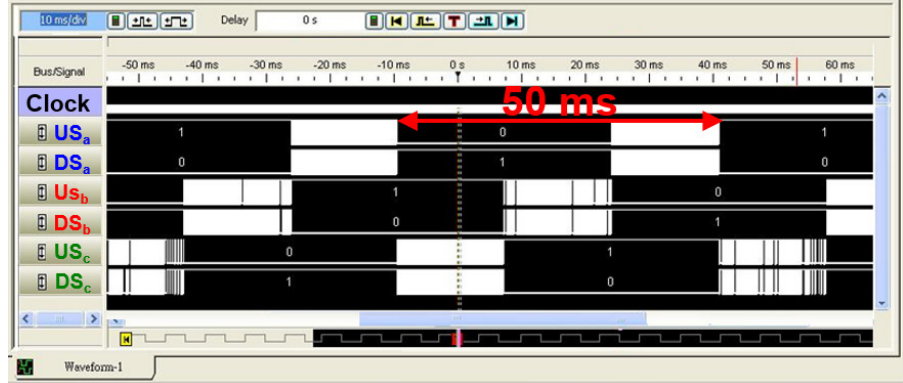
Figure 18. Behavioral simulation of waveforms of six–arm voltage signals of the inverter at a clock frequency of 10 MHz and a basic frequency of 1800 rpm (≈50 ms).